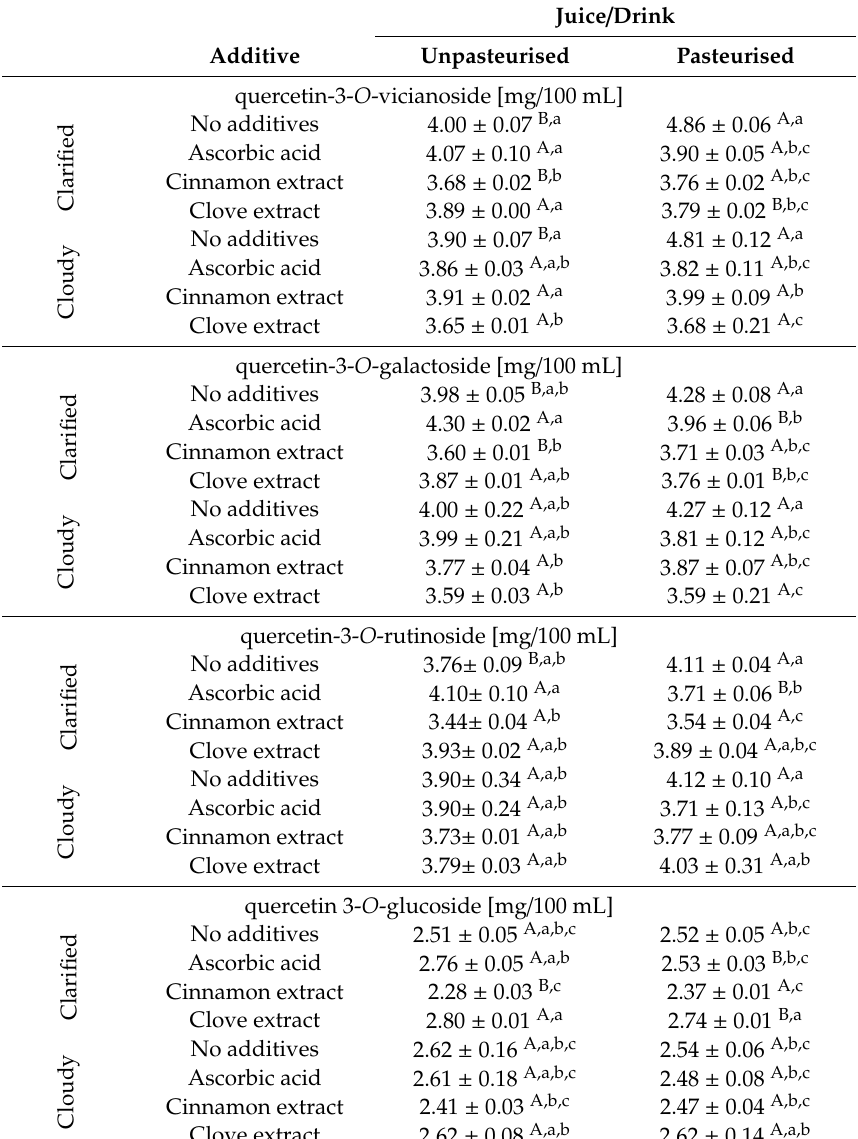
Table 2. Flavonol content before and after juice / drink